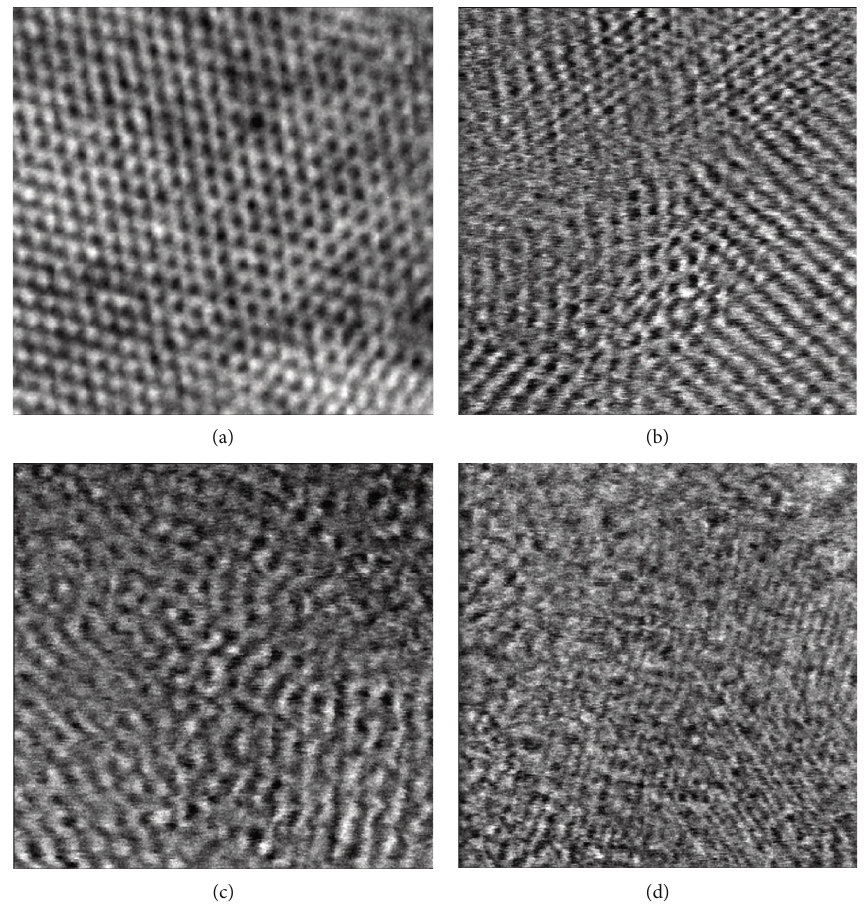
Figure 6: Selected region from micrographs showed in Figures 4 and 5, to see a typical HRTEM plan-view magni fi cation of (a) CdS, (b) CdS-SQ, (c) Zn Cd S, and (d) Zn Cd S-SQ solid 0.2 0.8 0.2 0.8